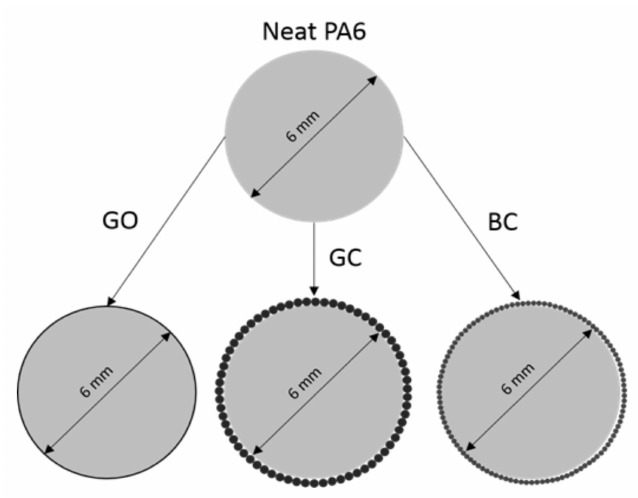
Figure 1. Schematic diagram of the covering of PA6 granules with carbon